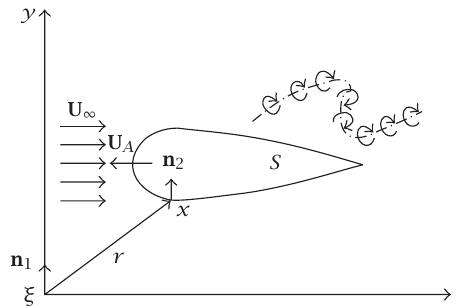
Figure 2.1 . A two-dimensional airfoil of surface S in an homoge- neous and inviscid